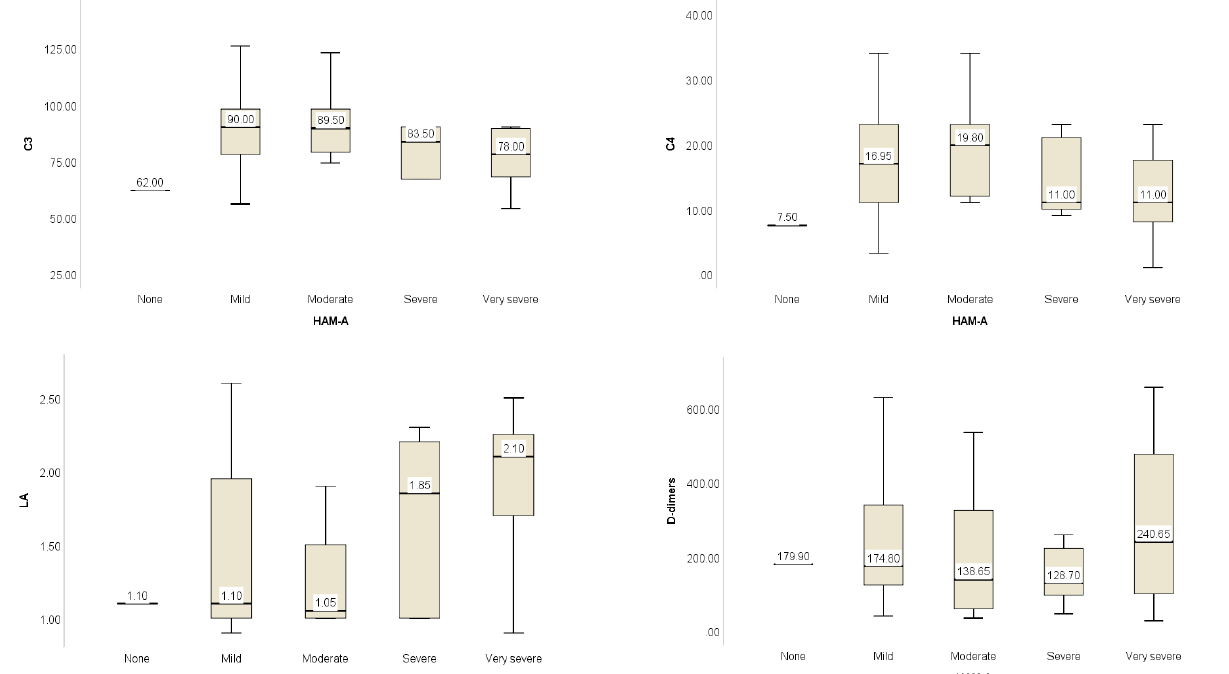
Figure 2. Biomarkers levels graphic representation based on anxiety categories (HAM A).